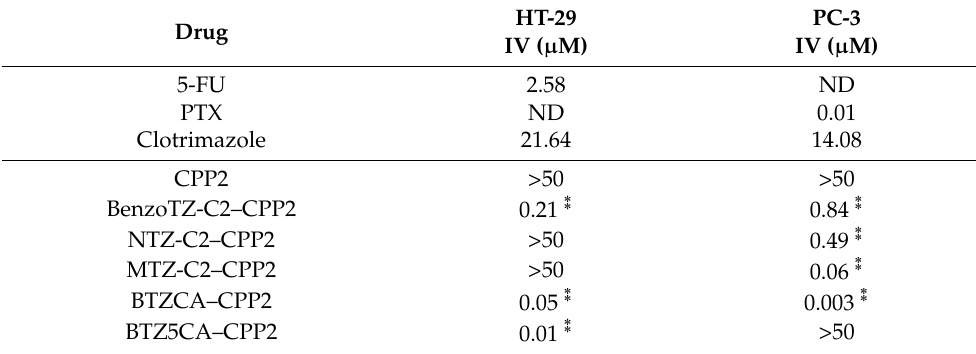
Table 1. Cytotoxicity of 5-FU, PTX, clotrimazole and CPP2–thiazole conjugates in HT-29 and PC-3 cells. IV values are given as the mean and were obtained by nonlinear regression using GraphPad software.